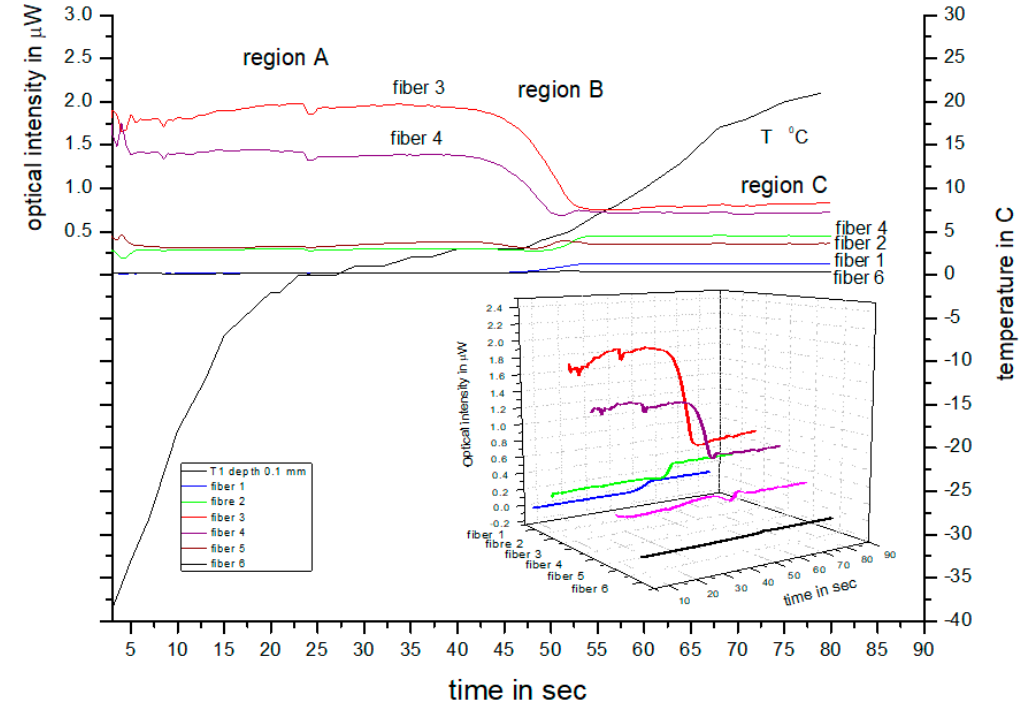
Figure 2. Timelines of intensities and temperature showing the temporal change in temperature and backscattering optical intensities from the six fibers during thawing [13].